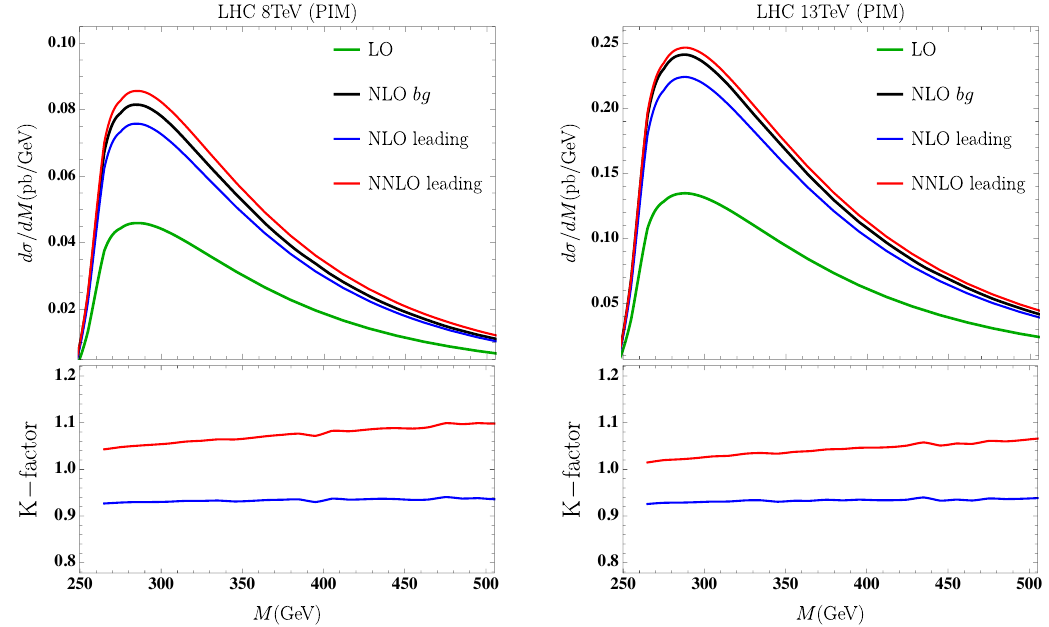
Figure 3 . Invariant mass distributions in the PIM scheme for tW (cid:0) production. In the upper plots, the black lines represent the NLO cross section from bg channel while the blue and red lines are the NLO leading and NNLO leading predictions, respectively. In the bottom plots, we show the ratio of NLO (NNLO) leading over NLO bg by blue (red) lines.